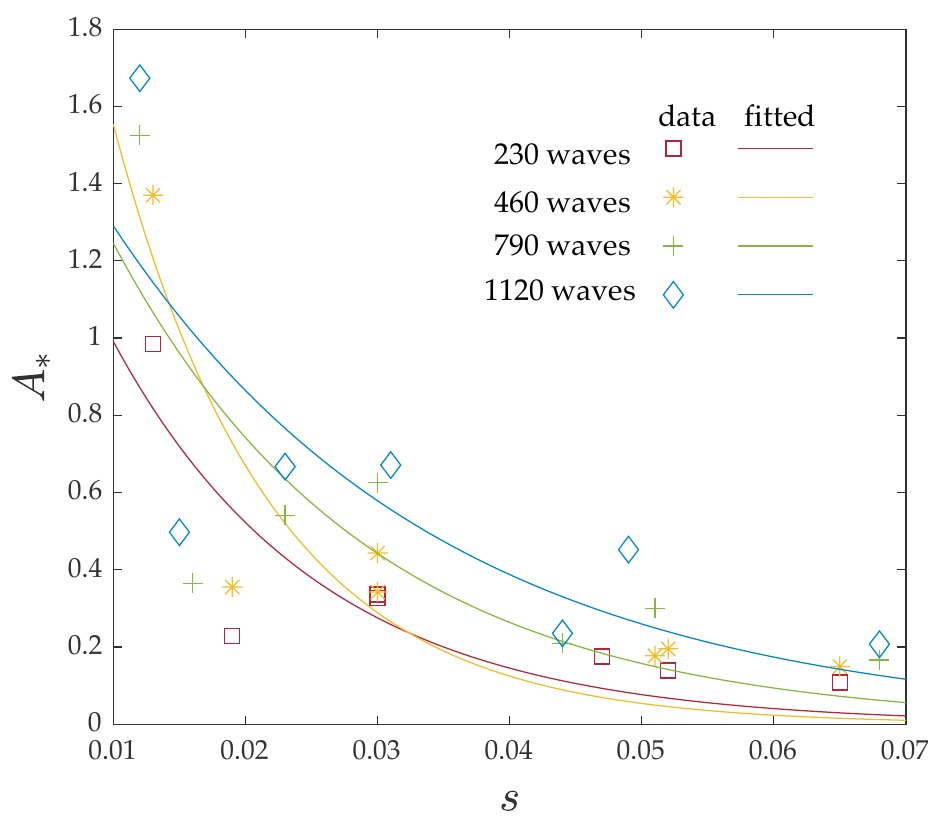
Figure 11. Normalized eroded area A ∗ after 230, 460, 790, and 1120 waves as a function of wave steepness s for tests DN1-DN7. Table 6. a and b as a function of N for tests DN1-DN7.